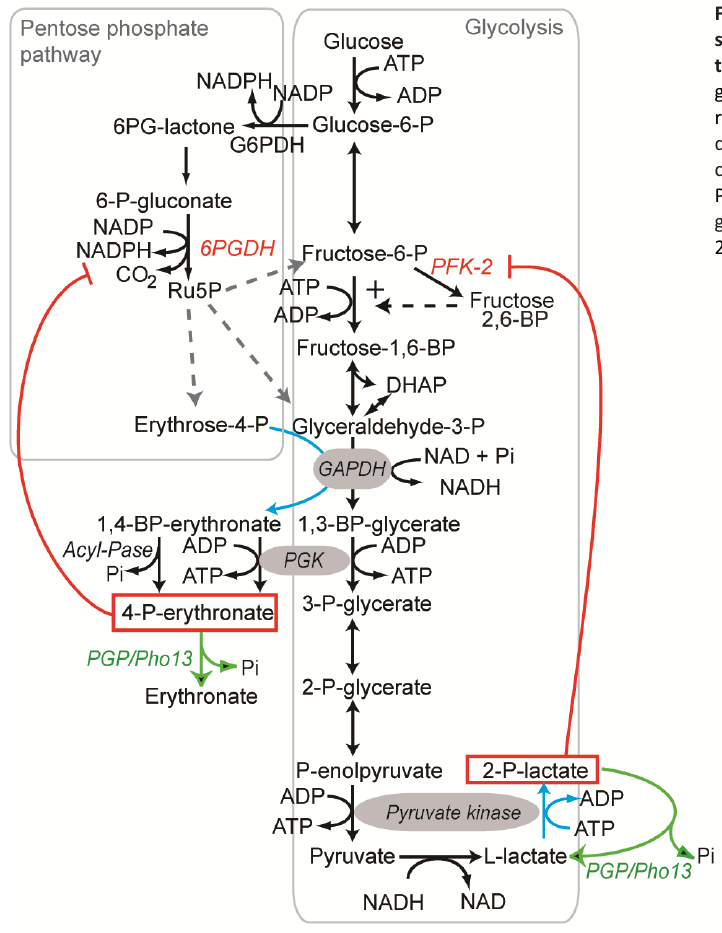
FIGURE 1: The enzyme PGP/Pho13 eliminates glycolytic side products and allows parallel action of glycolysis and the pentose phosphate pathway. Side activities of glycolytic enzymes are shown in blue; new metabolite repair activities in green and inhibitory interferences discovered or characterized in the paper of Collard